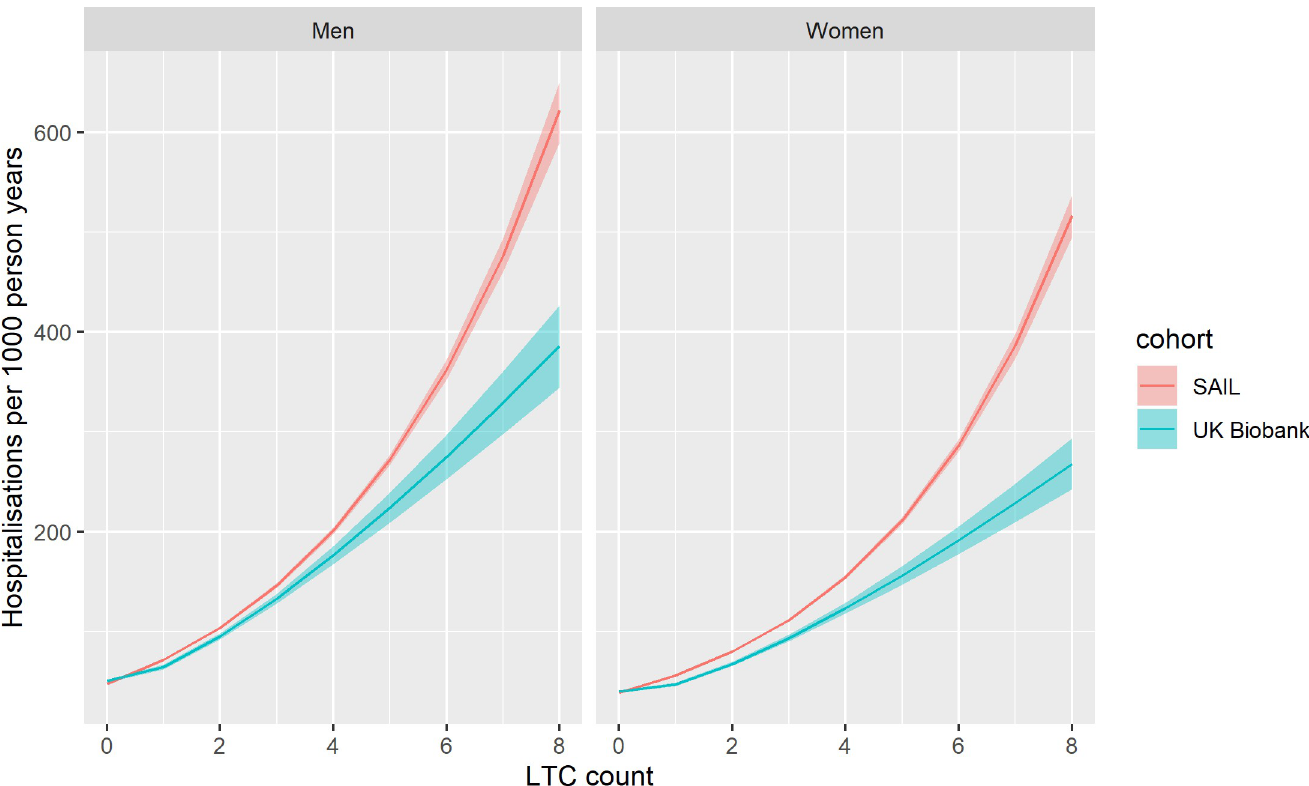
Fig 5. Relationship between LTC count and absolute risk of unscheduled hospitalisation for UK Biobank and SAIL. Lines indicate the modelled rate of unscheduled hospitalisations per 1,000 person years observation. Shaded area indicates 95% confidence interval. Predicted values are modelled at mean age for UK Biobank (56.5 years) and UK national mean Townsend score for socioeconomic status. LTC, long-term condition; SAIL, Secure Anonymised Information Linkage.